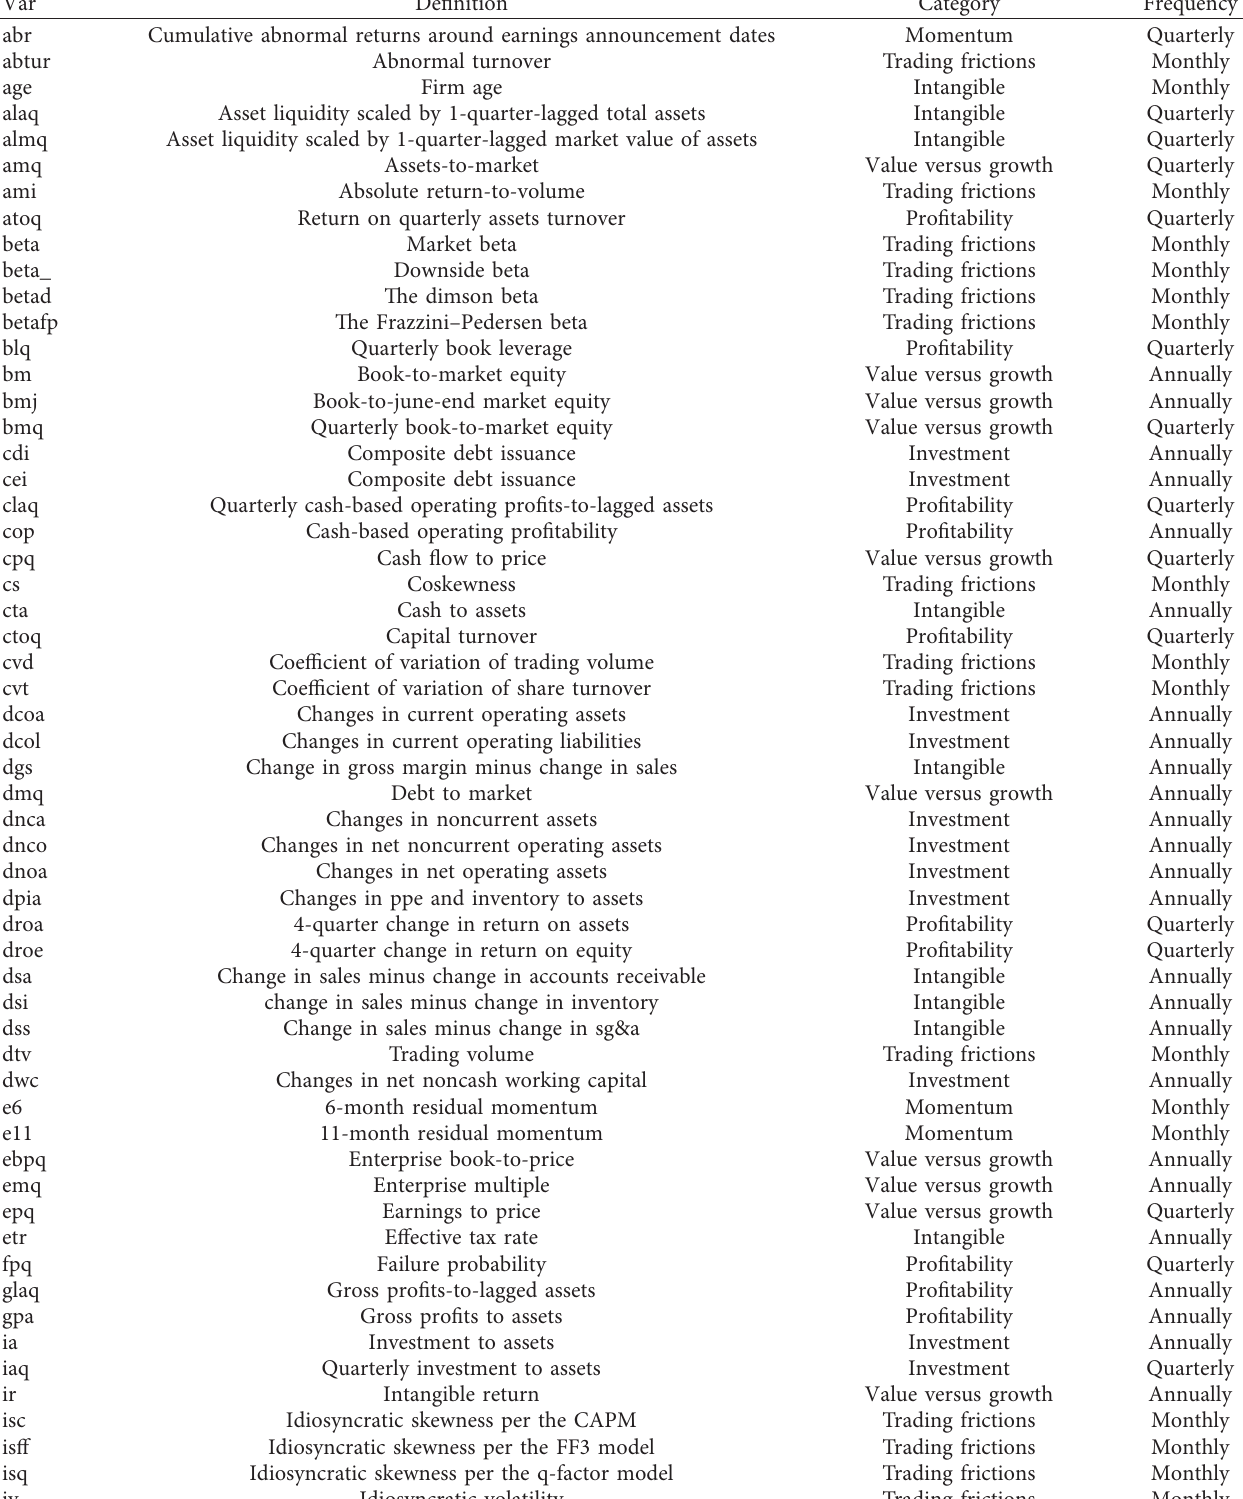
Table 1: List of characteristics. This table lists the acronyms, names, categories, and updating frequencies of 104 characteristics we consider in our empirical analysis. We build these characteristics using both trading and financial data from China Stock Market & Accounting Research Database (CSMAR), accessible at Wharton Research Data Service (WRDS). The inclusion of characteristics, construction details, and classification follow Hou et al. [9], recognizing the discrepancies between accounting standards in China and US